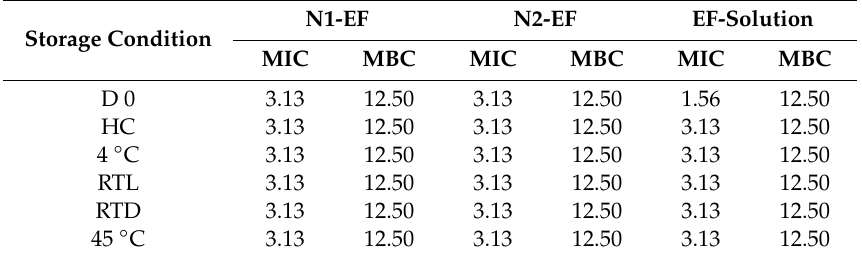
Table 7. Minimum inhibitory concentration (MIC) and minimum bactericidal concentration (MBC) values (mg / mL) of the extract-loaded nanoemulsions (N1-EF and N2)-EFand the extract solution (EF-solution) after storage in various conditions for 90